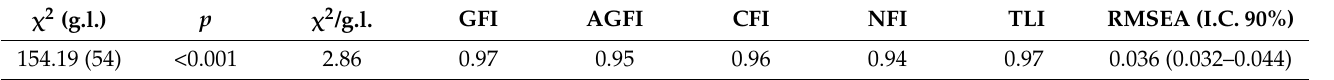
Table 3. AFC goodness-of-fit